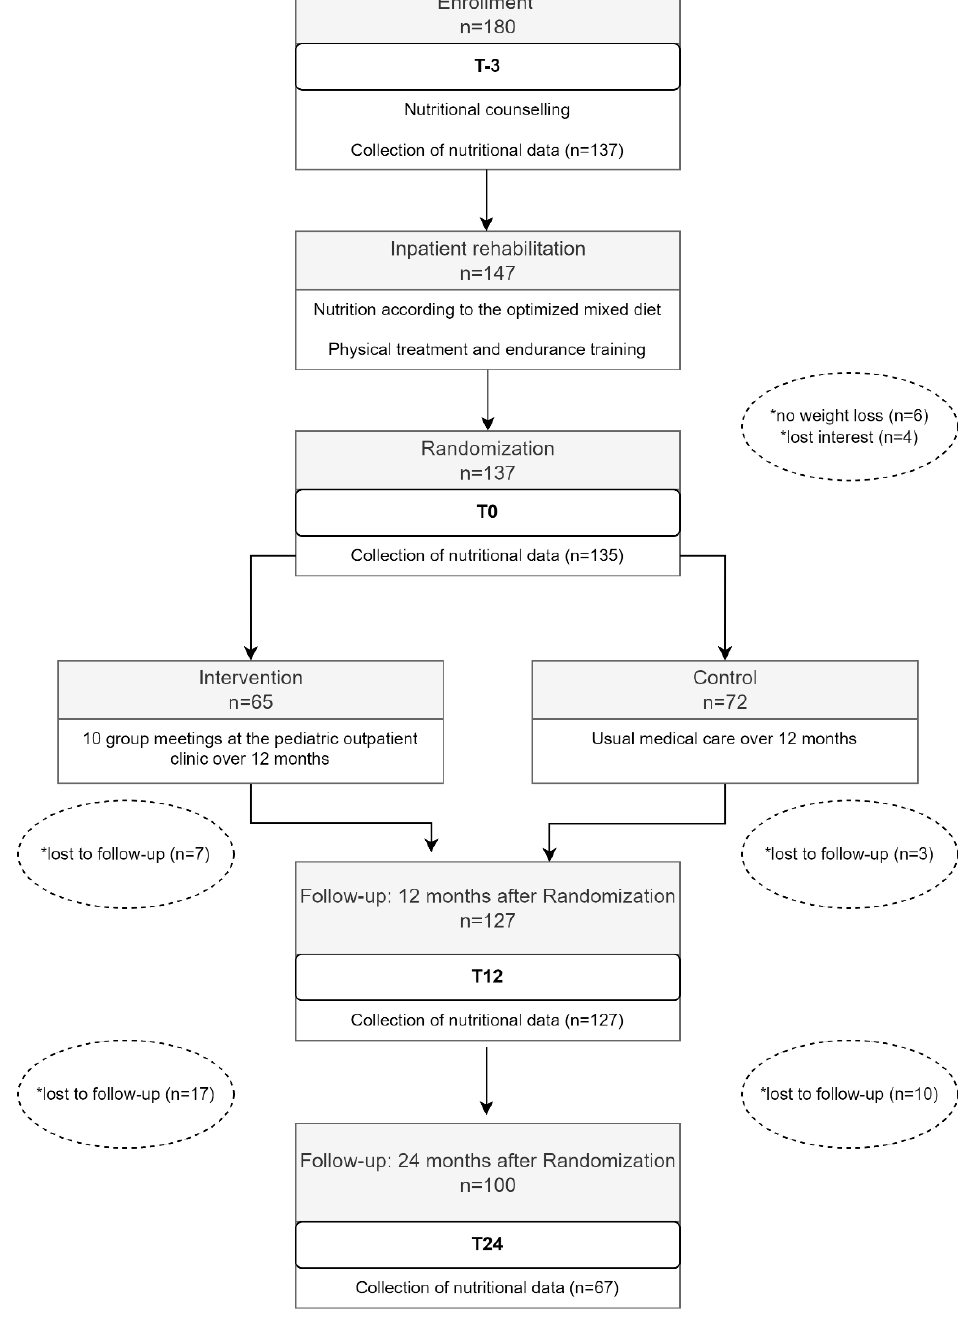
Figure 1. Collection of dietary intake data within the framework of the Maintain study. * Reasons for drop-out of study participants.